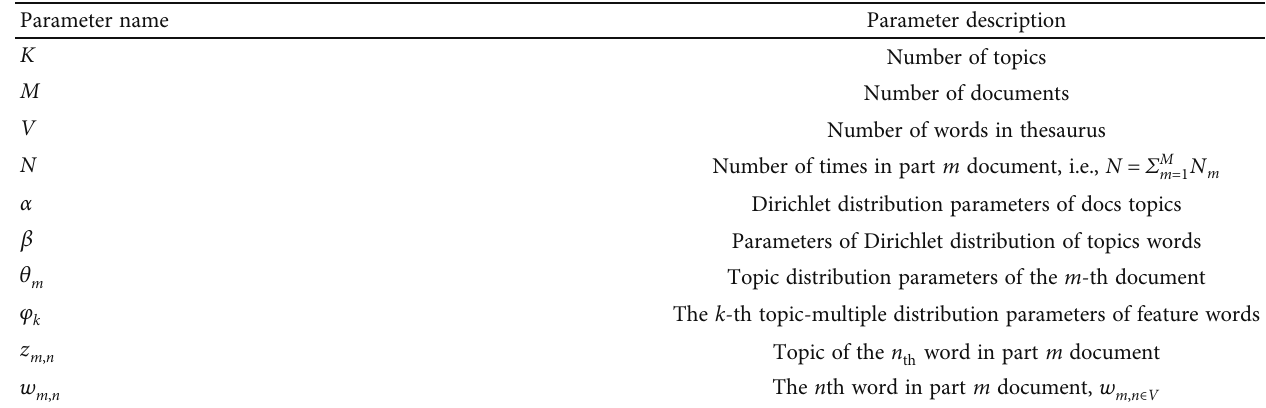
Table 1: LDA graph model parameter description.